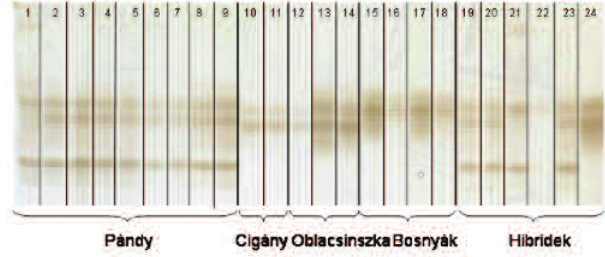
Figure 5. Silver stained microsatellite DNA profiles of the 24 investigated Hungarian sour cherry cultivars with primer pair PMS49 Table 3. Number and fragment size of the obtained fragments with the five SSR primer pairs Primer